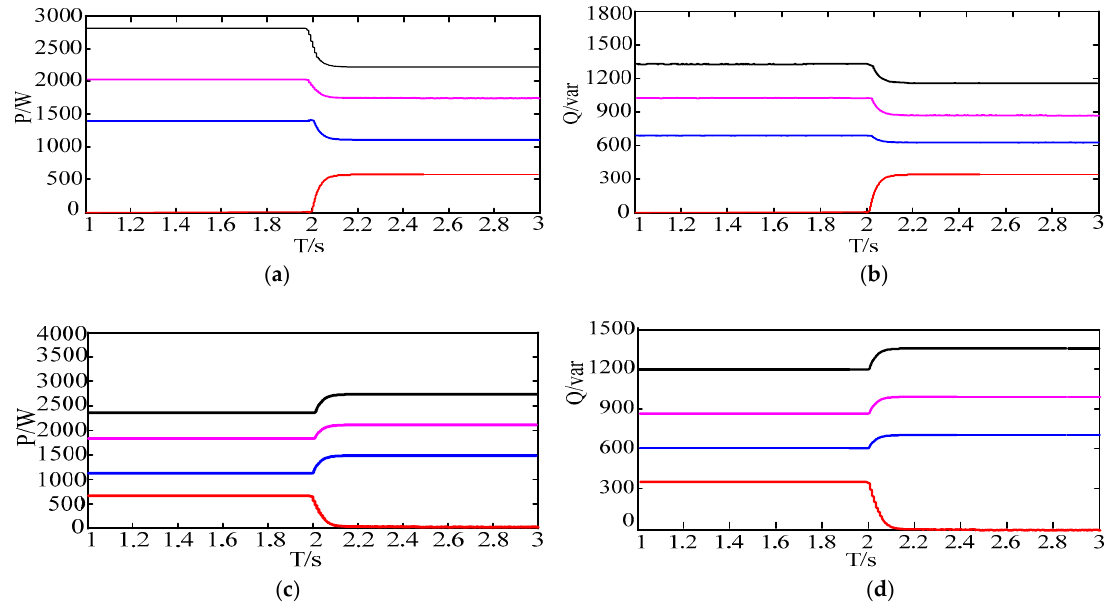
Figure 11. Variations of output power of DERs when DER disturbance occurs in the system. ( a ) The output active power of DERs with increasing Load2; ( b ) The output reactive power of DERs with increasing Load2; ( c ) The output active power of DERs with decreasing Load2; ( d ) The output reactive power of DERs with decreasing Load2.